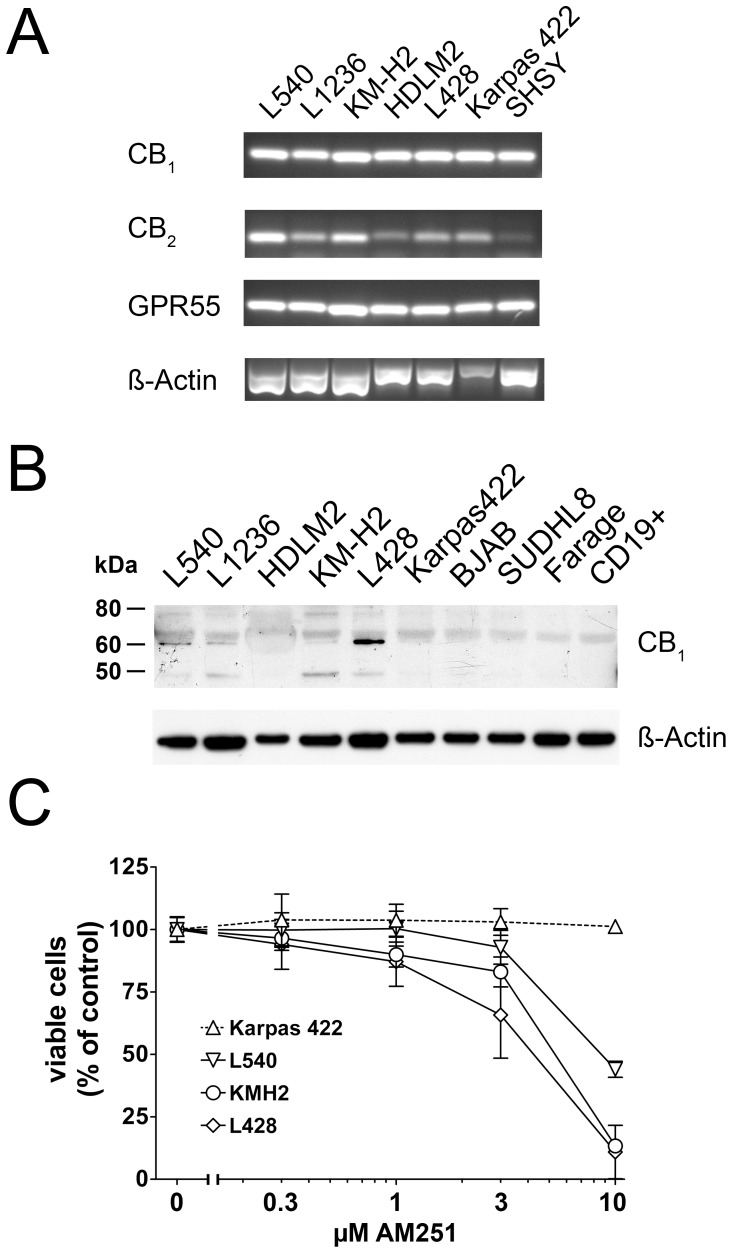
CB1-expression in B-cell derived cells and reduction of viability of cHL cells with AM251.A) Extracts of HL cell lines L540, L1236, KMH2, HDLM2, L428, as well as B-NHL cell line Karpas 422 and neuroblastoma derived cell line SHSY were used for mRNA analyses. After reverse transcription, cDNA templates were used to quantify mRNA transcripts of Cnr1, Cnr2, GPR55 and ß-actin. B) Western blot analysis for CB1–N in cHL (L540, L1236, HDLM2, KM-H2 and L428), B-NHL-derived cell lines (Karpas 422, BJAB, SUDHL8, Farage) and isolated peripheral blood CD19+ B-lymphocytes. ß-actin signal served as loading control. C) Cell viability was determined in L428, L540, KM-H2 and Karpas 422 cells treated with the indicated concentrations of AM251 for 120 h using the MTT-assay. Reduced viability of cHL cell lines was observed whereas viability of Karpas 422 cells was not affected. Values represent means ± SD.